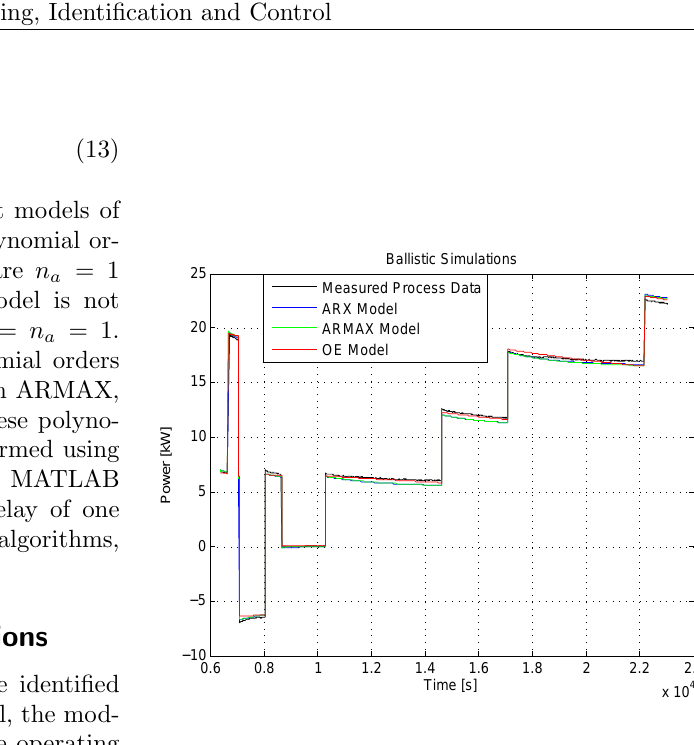
Figure 8: Ballistic simulations using the ARX model